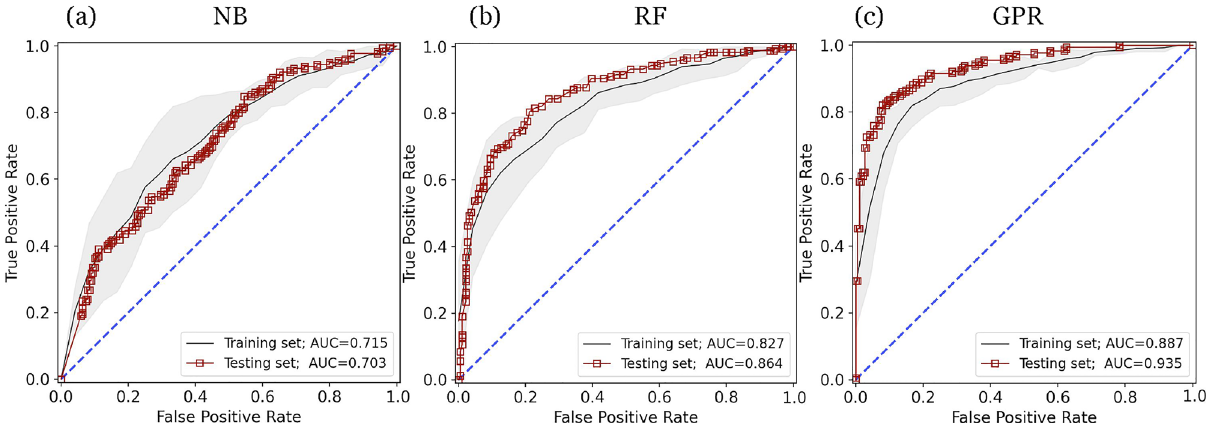
Figure 4. Example ROC curves for our radiomics-based ML models with the ( a ) NB, ( b ) RF, and ( c ) GPR ML classifiers on the training set (black lines) and on the test set (red squares). The gray range represents the mean ROC ± SD of the 5-fold cross-validation used on the training set. Matplotlib (version 3.4.3) (https:// pypi. org/ proje ct/ matpl otlib/3. 4.3/) is used for visualizing the data. We used 20 mm spherical ROI (SP20) with no FS for this example. AUC values are presented in the legends. The 20 mm SP ROI was used for visualization purposes. Full data is available in the supplementary dataset 62